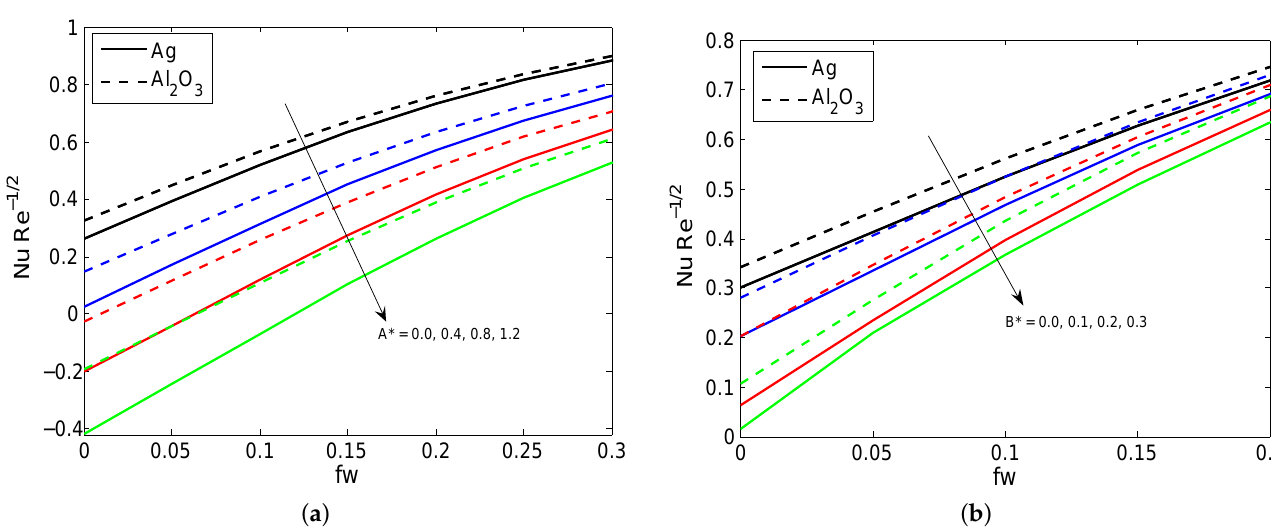
Figure 9. LNN variation for diverging values of ( a ) A ∗ and ( b ) B ∗